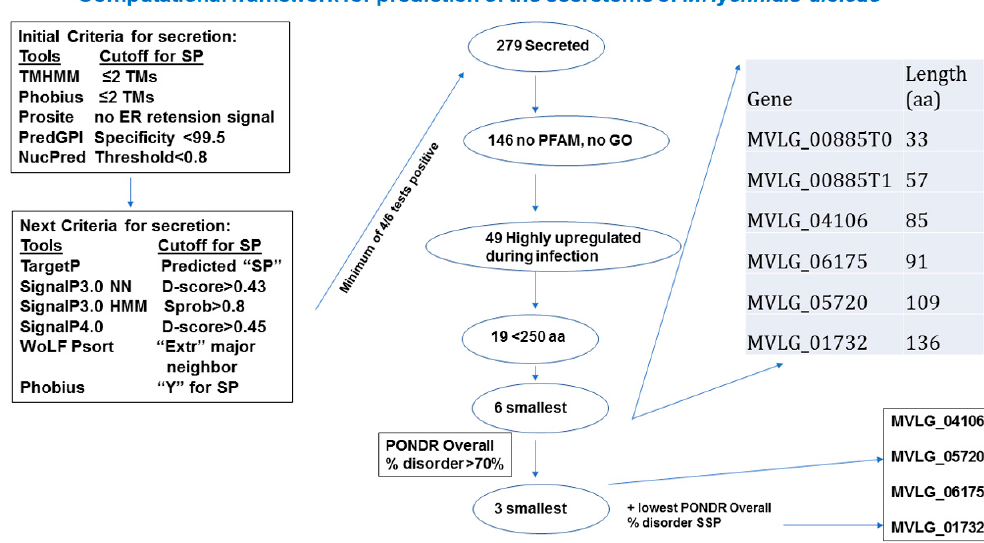
Figure 5. Computational framework for prediction of secretome for M. lychnidis-dioicae and selection of candidate effectors for further analyses. Detailed description of tools and cut-off criteria for secretome prediction and prediction of disorder are provided in Supplementary Methods. Numbers tally for proteins at each stage of secretome prediction are provided in tab 3 of Table S1. TM,